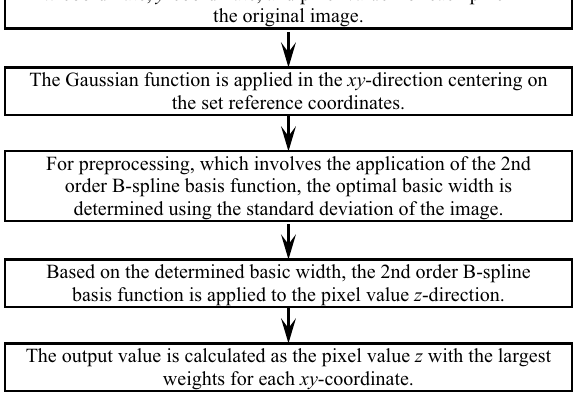
Figure 2. Processing procedure of the abwFMGFI.